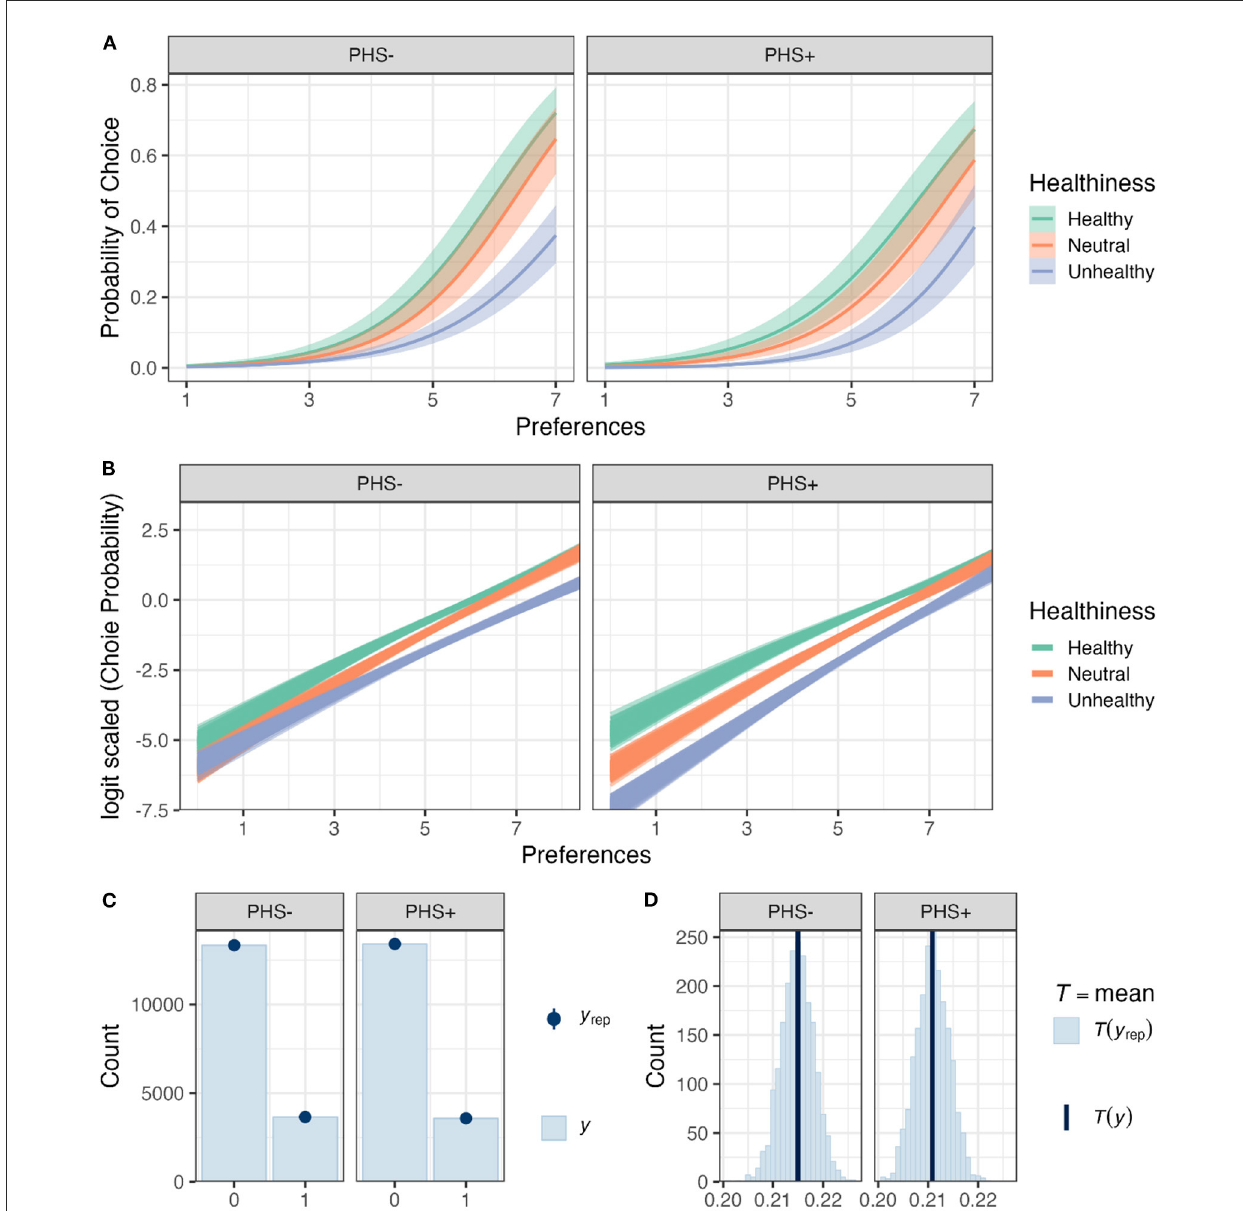
FIGURE6 The relationship of food preferences and choice behavior in the supermarket task. (A) Choice probabilities as a function of preferences based on model predictions for different food categories and PHS conditions. Solid lines and shadows represent means and standard errors based on posterior distributions, respectively. (B) Choice probabilities in logit scale as a function of preferences based on model predictions for different food categories and PHS conditions. In total, 200 lines are shown for each condition, where each line presents a posterior prediction. (C) A bar plot ( y ) of the data obtained from the choice behavior (i.e., the model’s outcome) depicting the distribution of the observations. The blue dots and lines ( y rep ) represent mean and standard error estimates obtained from posterior distributions of the full Choice-Preference Function. (D) Frequency density bar plots showing the estimated ( y rep ) and observed mean choice behavior ( y ) in the two PHS conditions.